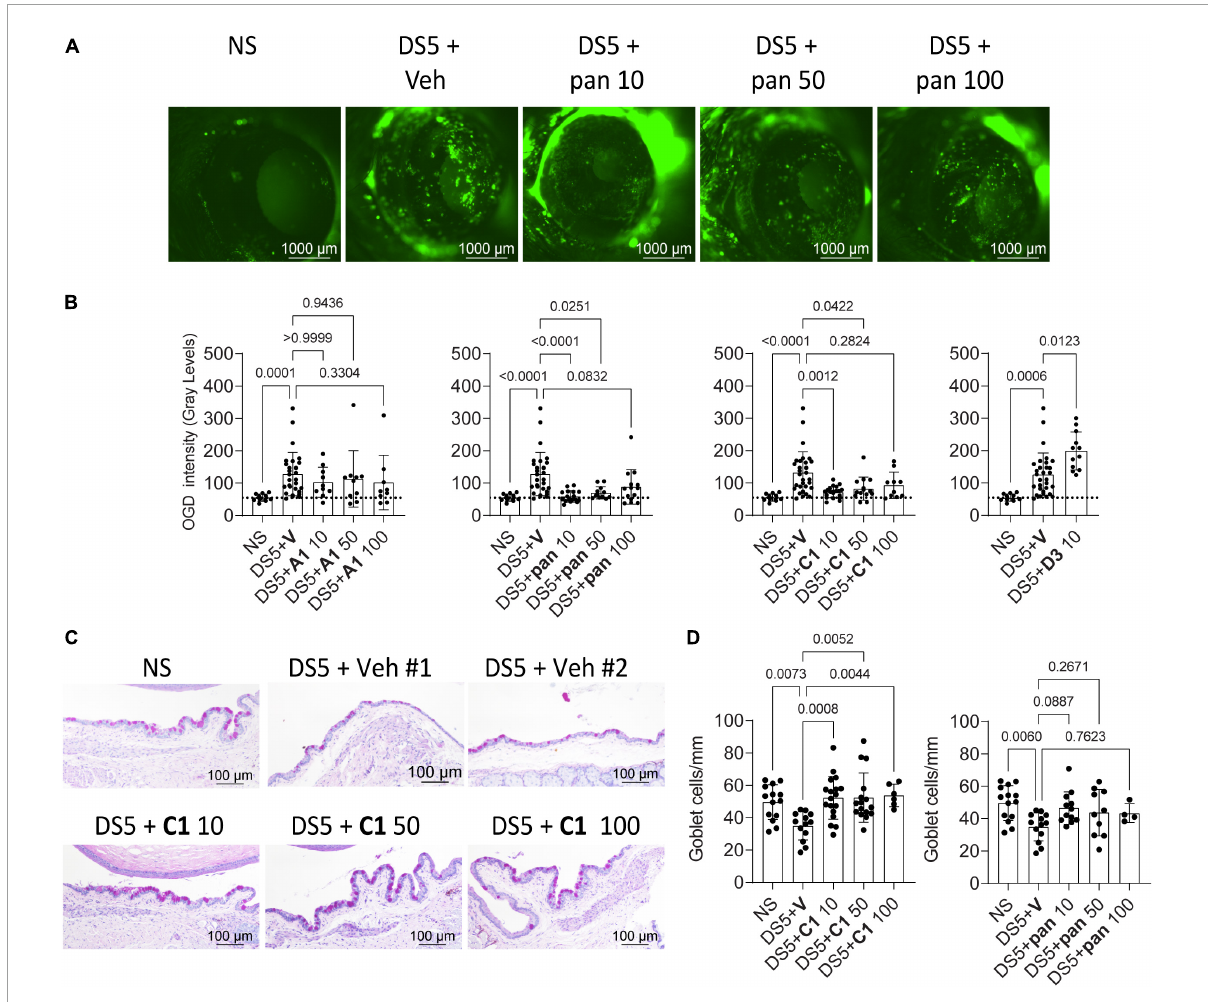
FIGURE1 Small molecules improve dry eye disease. (A) Representative images of C57BL/6 mice corneas stained with Oregon-green Dextran (OGD) after the mice were subjected to desiccating stress for 5 days (DS5) with topical vehicle or eye drops containing increasing concentrations of pan. Numbers after the compound indicate the concentrations (10, 50, or 100 µ M). NS, non-stressed, naïve controls. Scale bar = 1,000 µ m. (B) Cumulative corneal barrier evaluation in mice subjected to desiccating stress for 5 days (DS5). Mice receiving eye drops of either A1, C1, pan, or D3 (Tavilermide) or vehicle (Veh). Numbers after the compound indicate concentrations (10, 50, or 100 µ M). Each dot represents one animal (average of right and left eyes, n = 11–31). Non-parametric Kruskal–Wallis non-parametric test followed by Dunn’s comparison. P-Value as shown. (C) Representative images of conjunctival sections stained with PAS (purple-magenta) showing increased goblet cell density after topical treatment with C1. (D) Cumulative graph of conjunctival goblet cell density. Non-parametric Kruskal–Wallis followed by Dunn’s multiple comparison test. Scale bar = 100 µ m. Each dot represents one animal, n = 5–18. P-value as